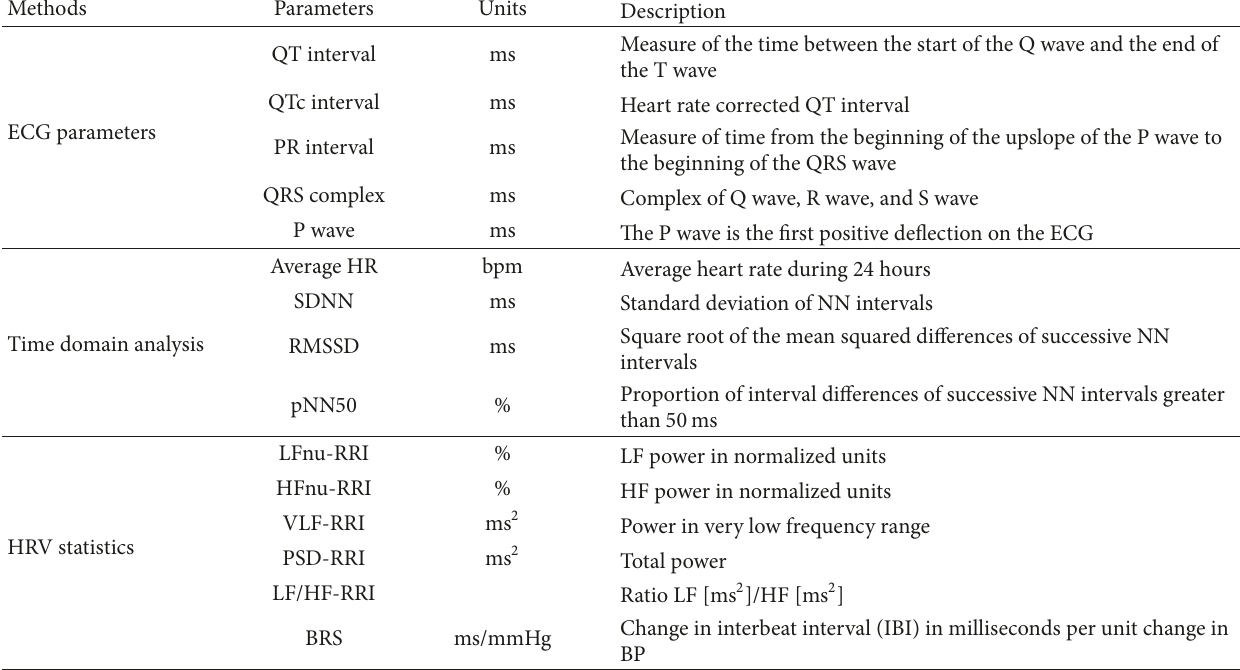
Table 1: Detailed description of input variables used in this